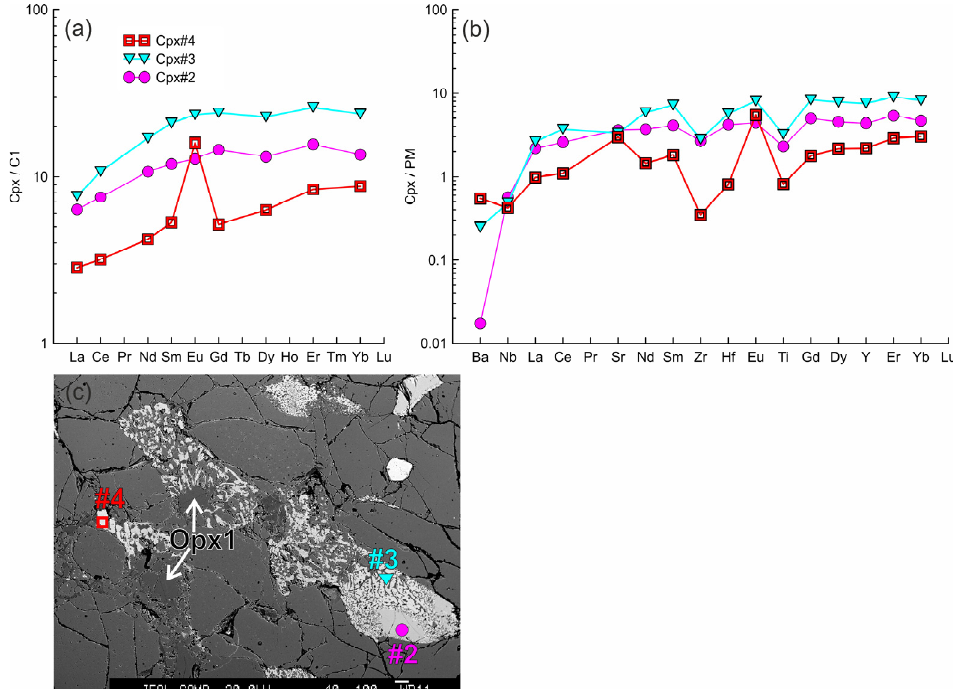
Figure 9. ( a , b ) The trace element composition of the clino- and orthopyroxenes from sample HD2 (xenolith of 1.5 cm in size) normalized to the CI chondrite [31] ( a ) and primitive mantle [31] ( b ). Cpx 1 (#2) with a wide reaction zone of Cpx2 (#3) at contact with the orthopyroxene reaction zone. Cpx3 (#4) from the reaction zone of Opx1. ( c ) Image showing different widths of pyroxene reaction zones. Clinopyroxene located in the upper right corner contacts olivine only and shows a narrow reaction zone.